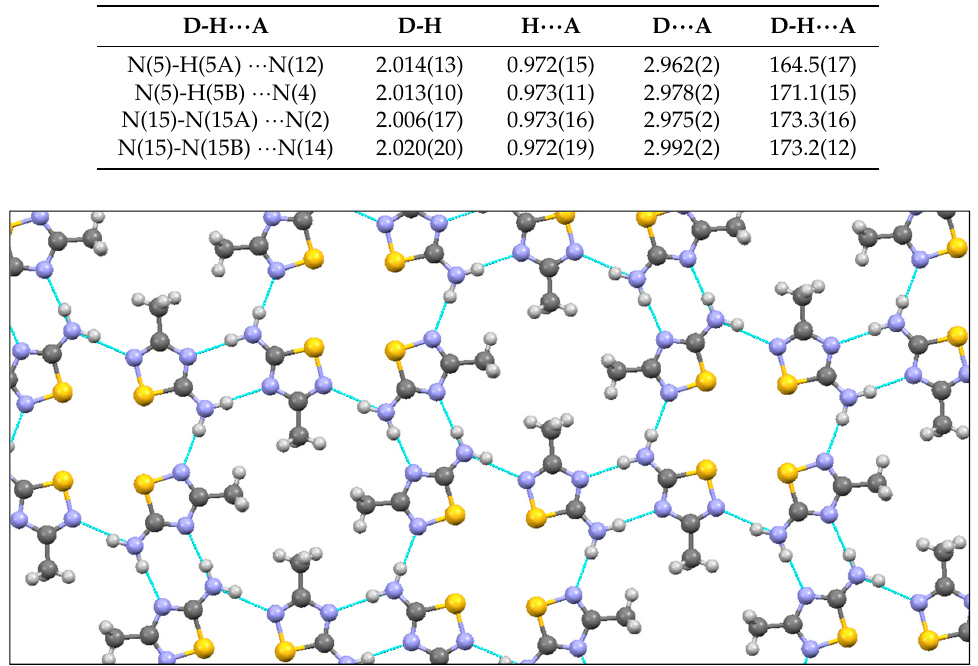
Figure 3. Two-dimensional hydrogen bonded network in the structure of 1 .